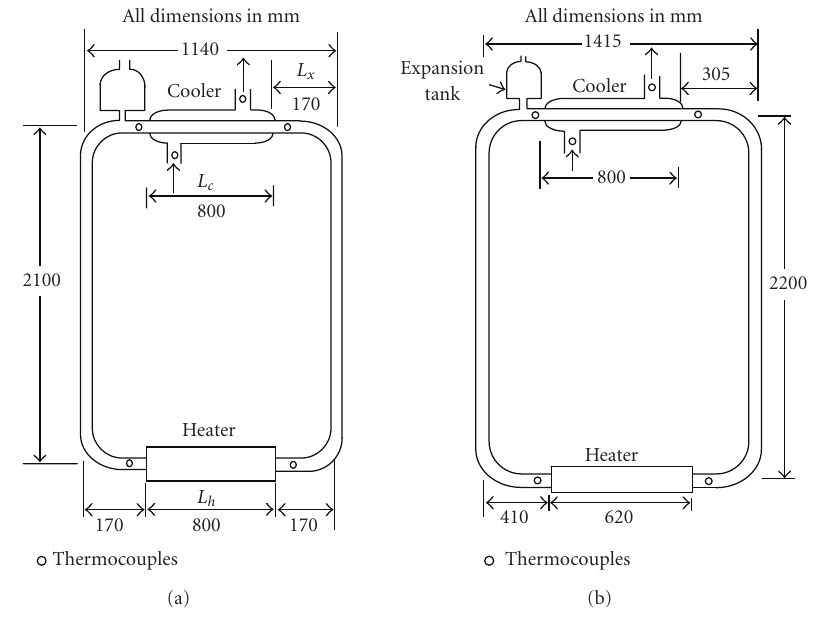
Figure 1: Schematic of the experimental